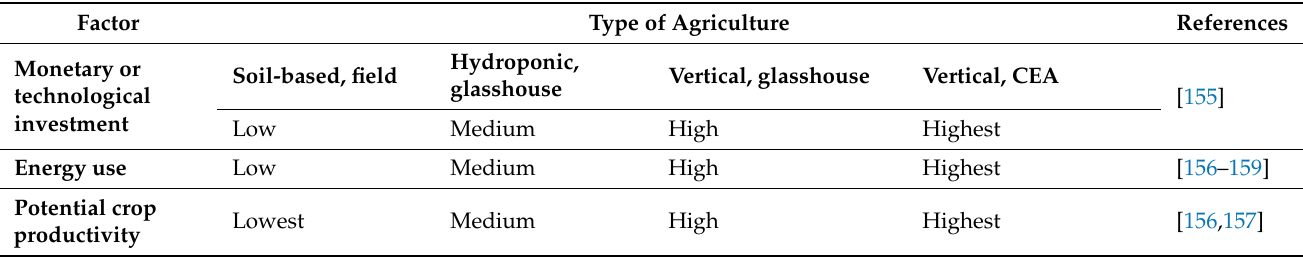
Table 2. A summary of considerations for different staple types of traditional, hydroponic, and vertical farming